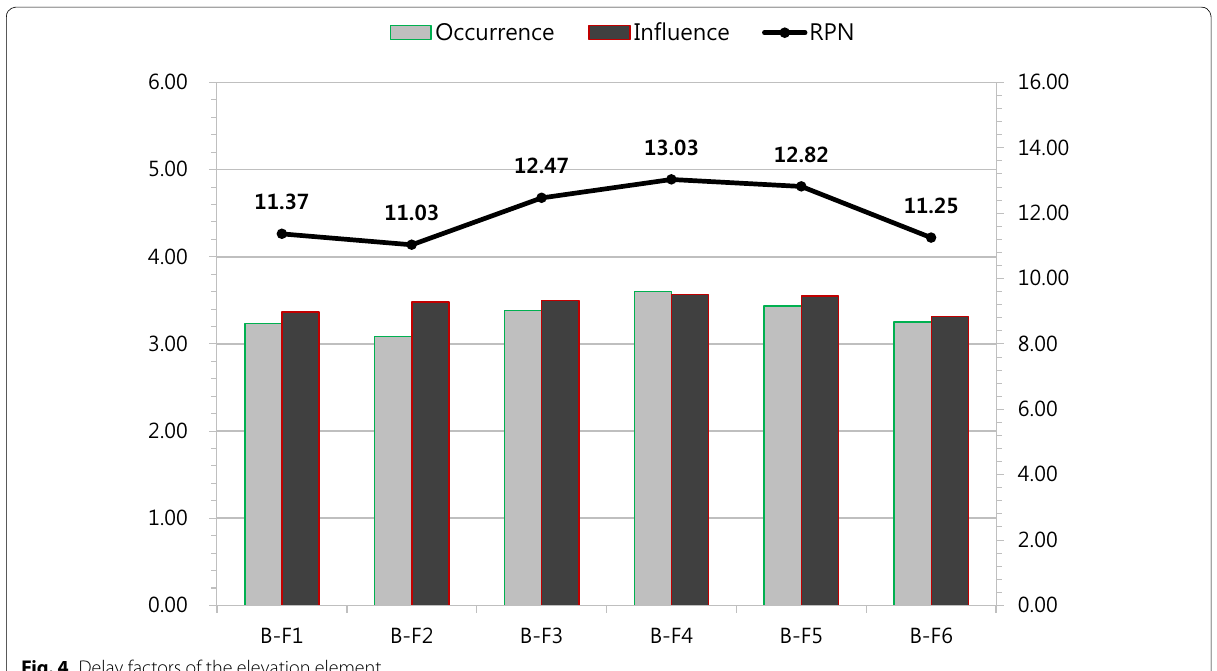
Fig. 4 Delay factors of the elevation